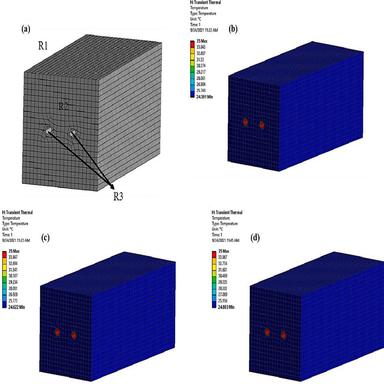
Simulation results obtained using ANSYS for (b) 3 % SCF (c) 5 % SCF (d) 10 % SCF.